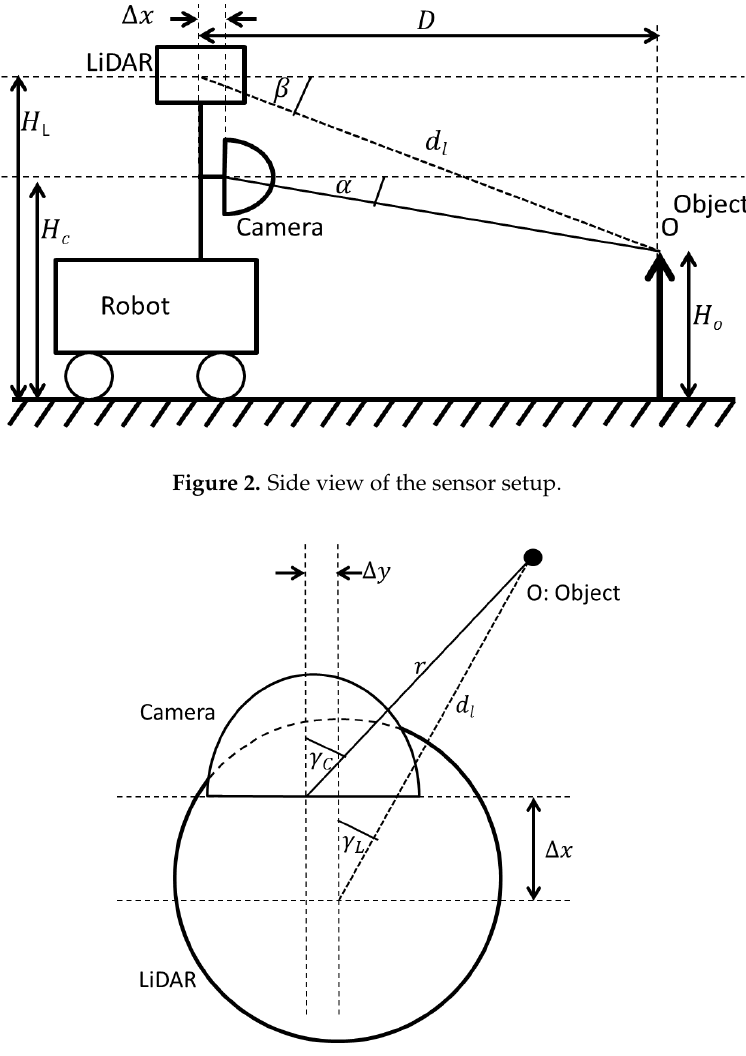
Figure 3. Top view of the sensor setup.